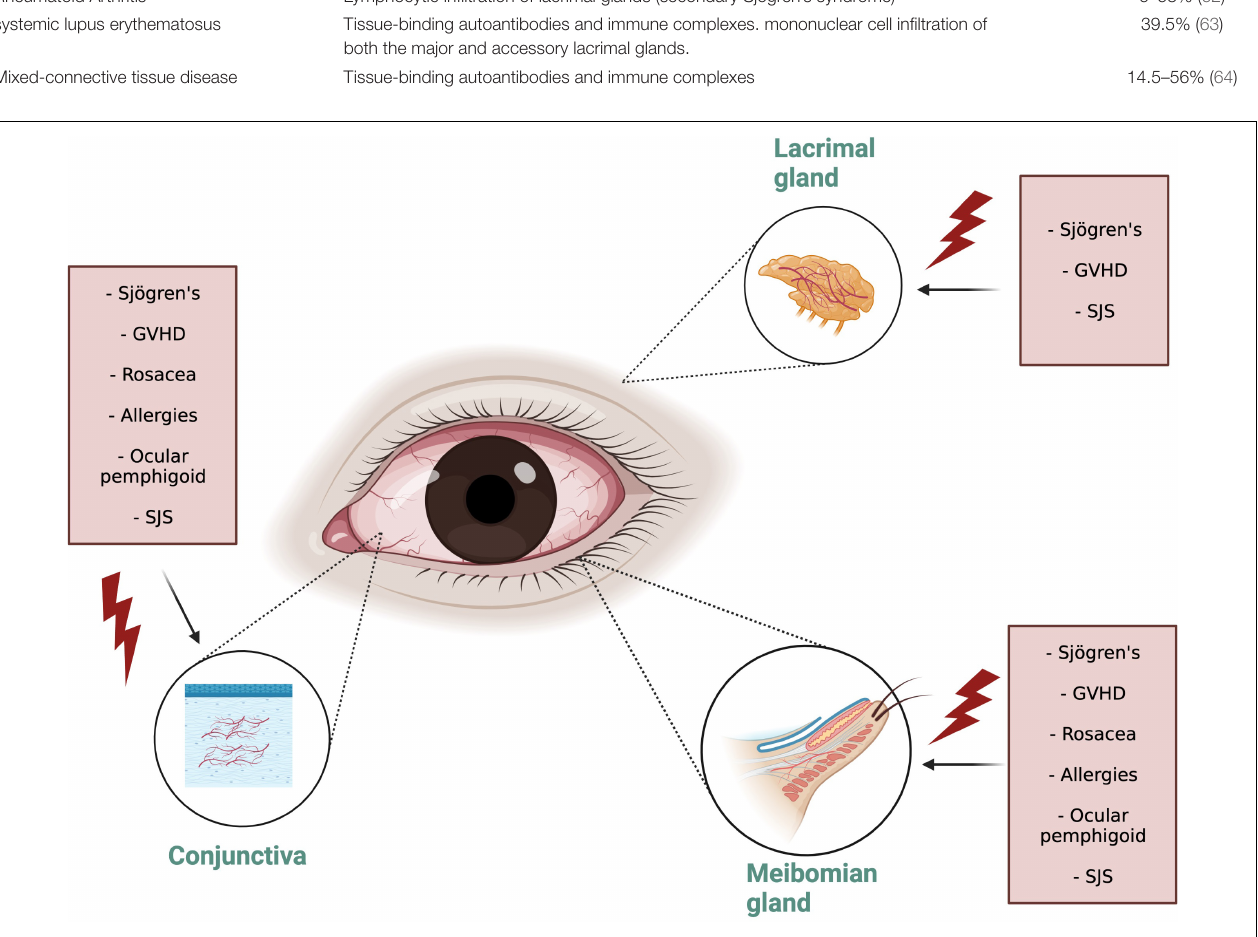
FIGURE 1 | Ocular Surface Inflammatory Disorders (OSID) target organs. Note that the Diverse OSID impact in different degrees all the adnexal connective tissue structures. OSID, ocular surface inflammatory disorders; GVHD, graft versus host disease; SJS, Stevens Johnsons